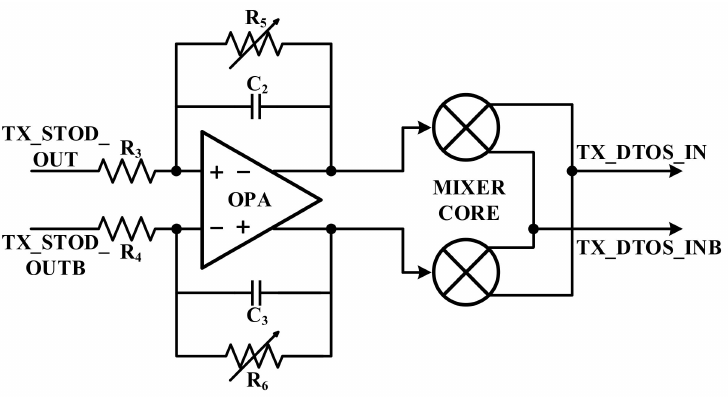
Figure 11. Block diagram of transmitter mixer.